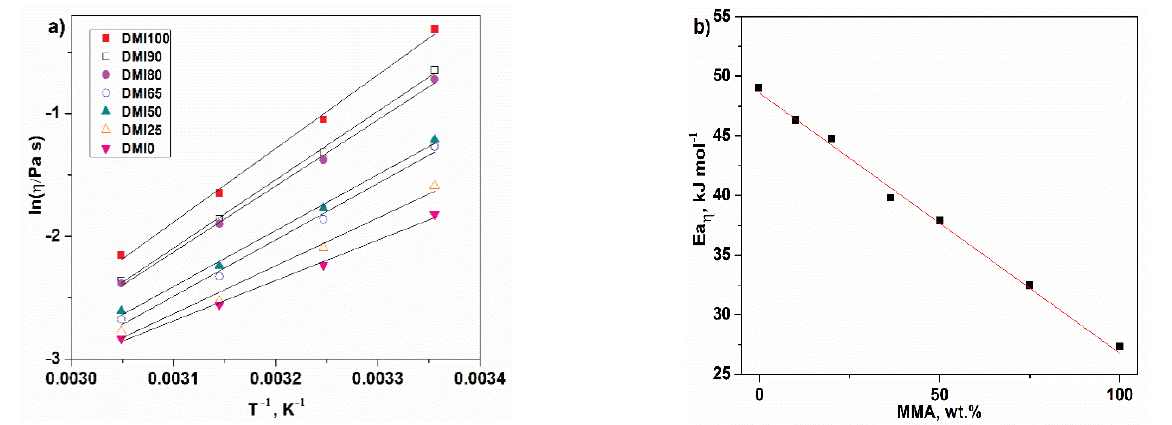
Figure 3. ( a ) ln η as a function of 1/T at the constant shear rate (10 s − 1 ); ( b ) Ea as a function of MMA content in the reactive diluent.